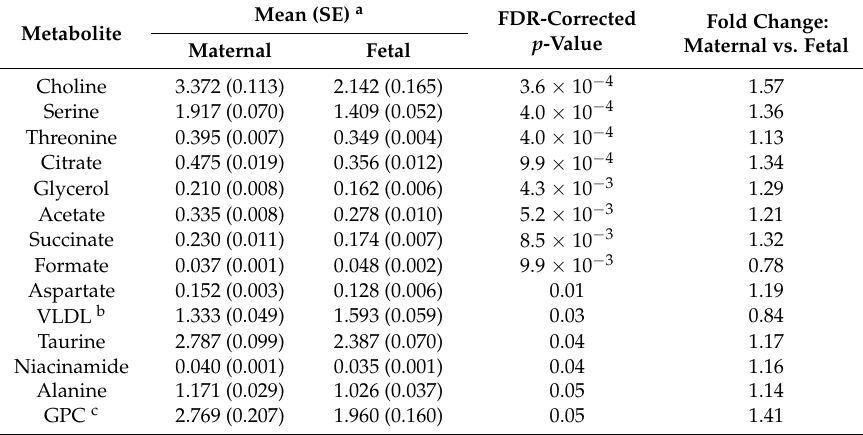
Table 1. Metabolites identified on maternal and fetal surfaces of the placenta at 15 min